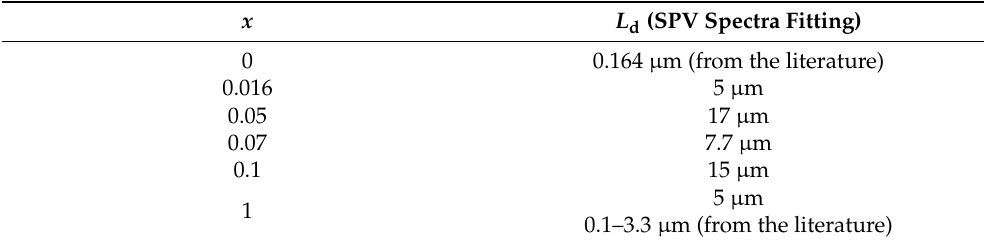
Table 2. Collected data of diffusion lengths of carriers for CdS 1 − x Te x samples.